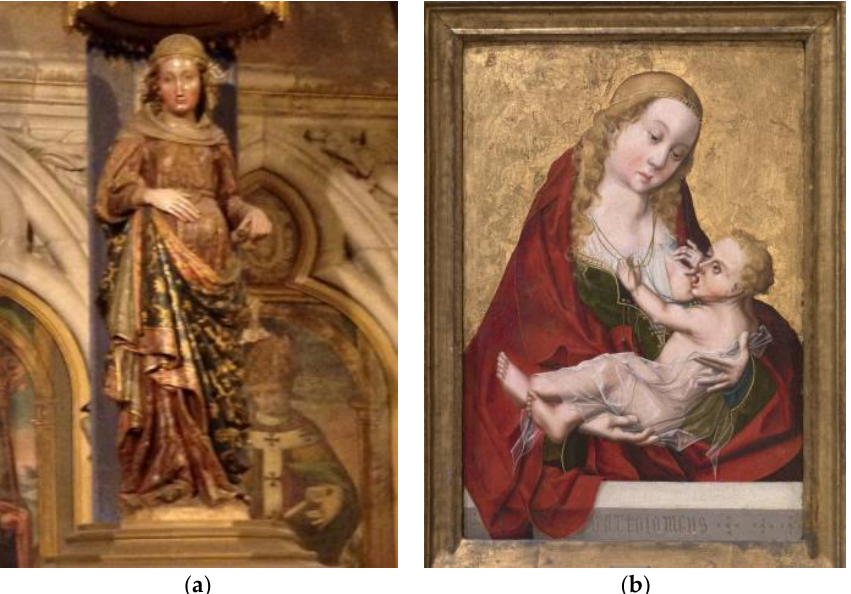
Figure A4. ( a ). Our Lady of Hope, late thirteenth century, Leon Cathedral (Leon, Spain). ( left ) ; ( b ). Maestro Bartolomé, “Virgen de la leche,” 1490, Museo Del Prado (Madrid, Spain). ( right ).